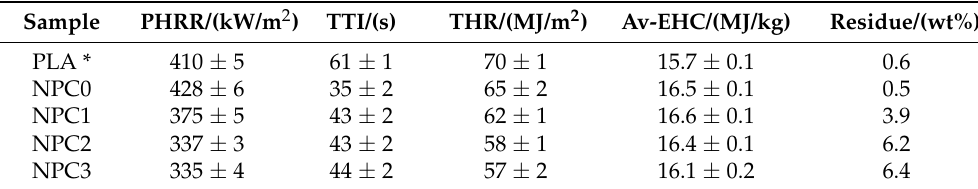
Table 5. Results from CCT for PLA-OCC biocomposites.